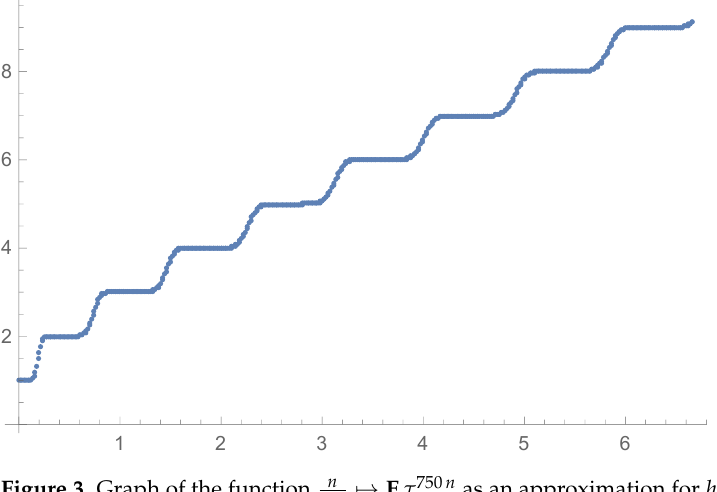
(cid:55)→ E τ 750 n as an approximation for h ( x ) . Figure 3. Graph of the function n 750 Asymptotic (20) for P r ( τ mn = k ) , k = 1 implies that h ( x ) cannot be (right)